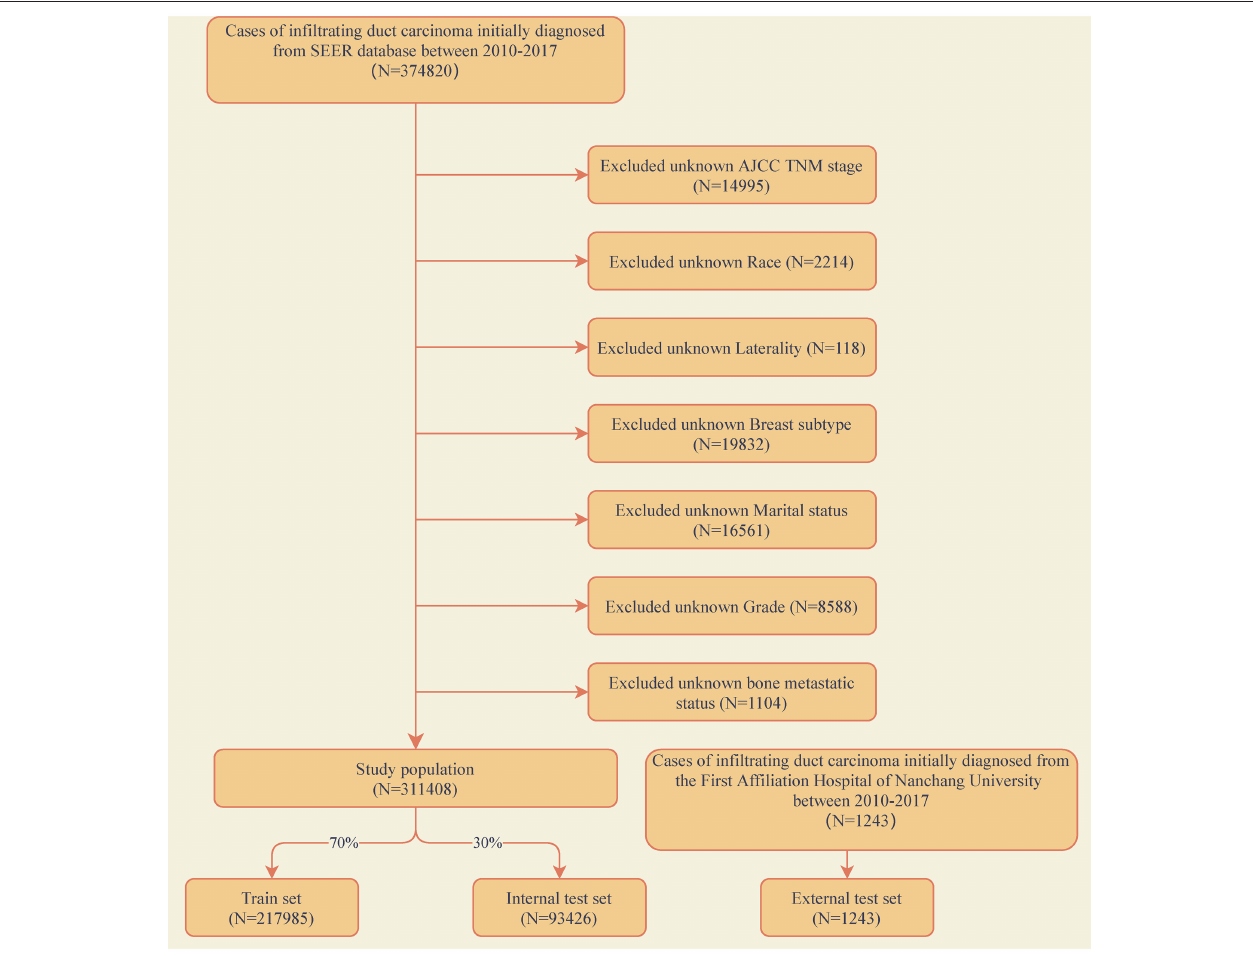
FIGURE 1 | Flow diagram of the study population selected from the Surveillance, Epidemiology, and End Results (SEER) database and the First Affiliated Hospital of Nanchang University. According to the inclusion and exclusion criteria, a total of 311,408 patients of SEER were included in this study, and they were randomly cut into the training and internal test sets in a 7:3 ratio. Data from the First Affiliated Hospital of Nanchang University ( n = 1,243) as an external test set.